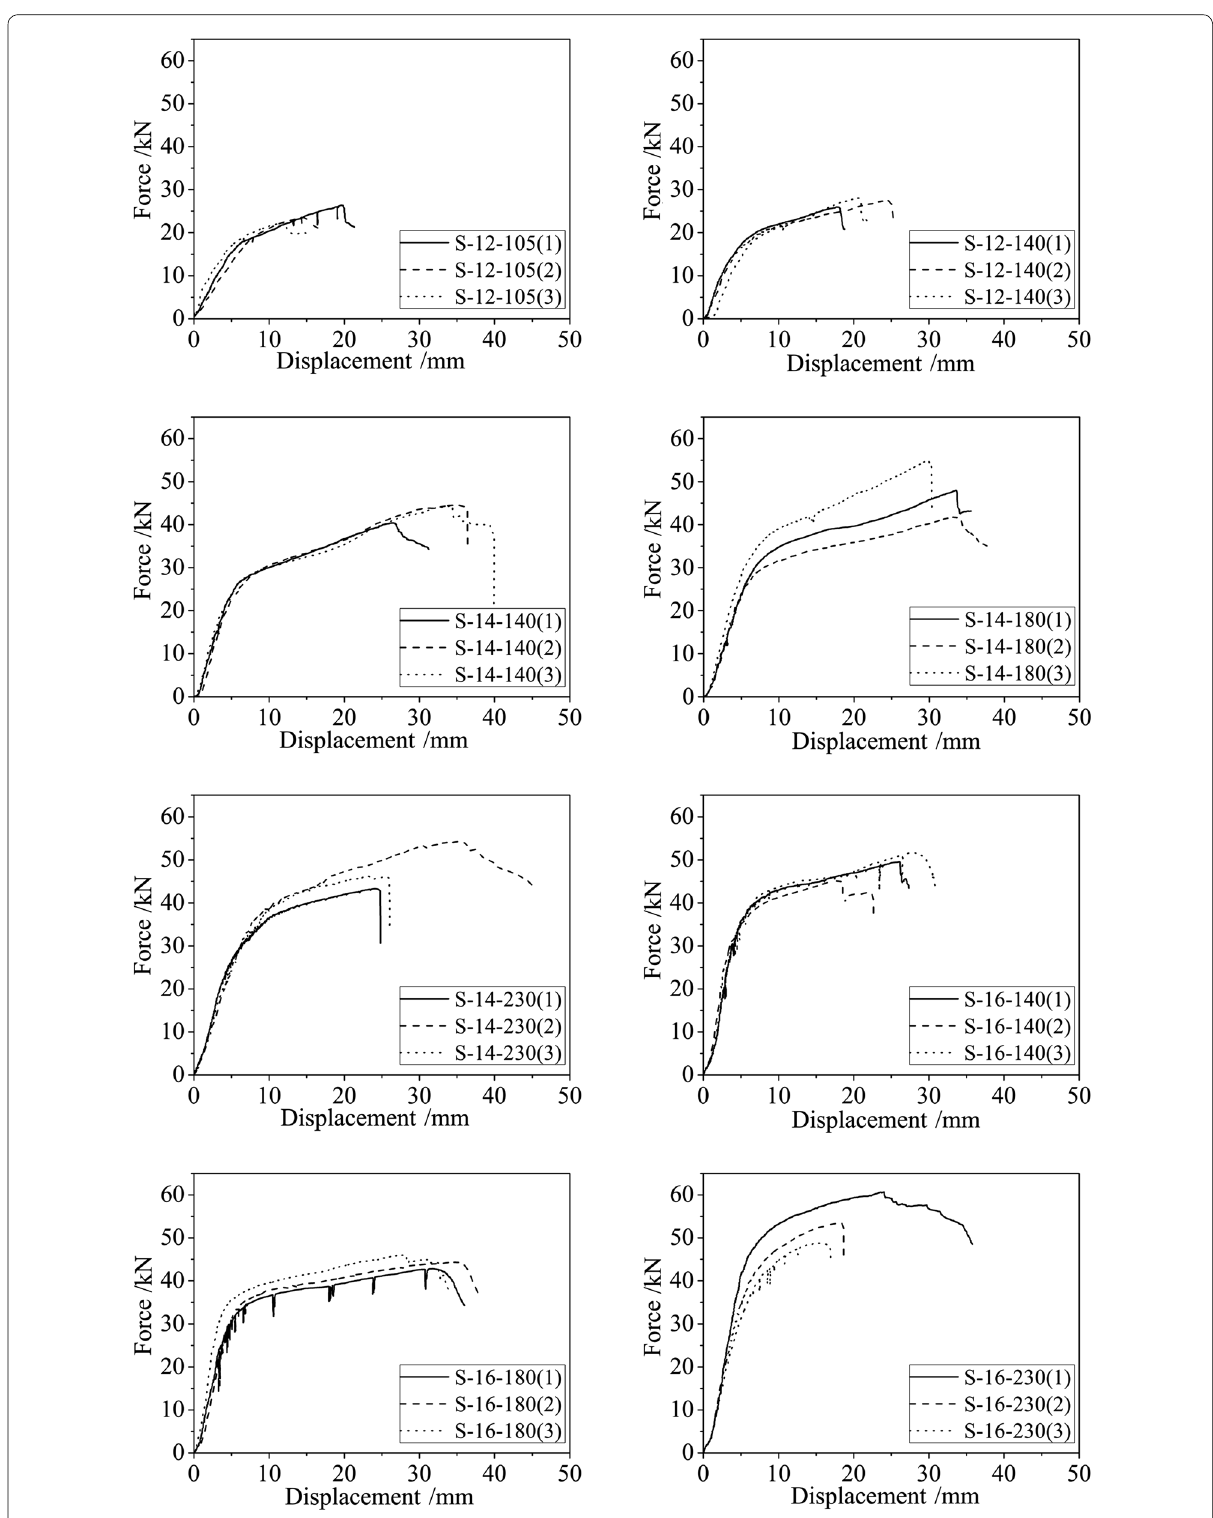
Fig. 6 Force–displacement curves of the